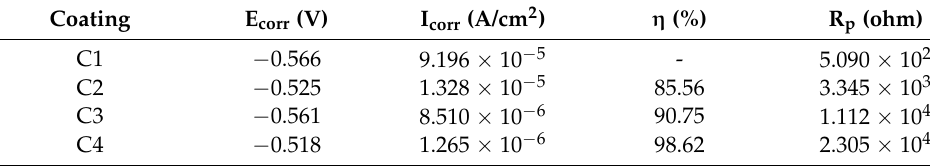
Figure 9. Tafel curves for C1, C2, C3, and C4 after immersion for 31 d. Figure 9 . Tafel curves for C1, C2, C3, and C4 after immersion for 31 d. Table 3. Basic performance parameters of graphene Table 3. Basic performance parameters of graphene oxide.